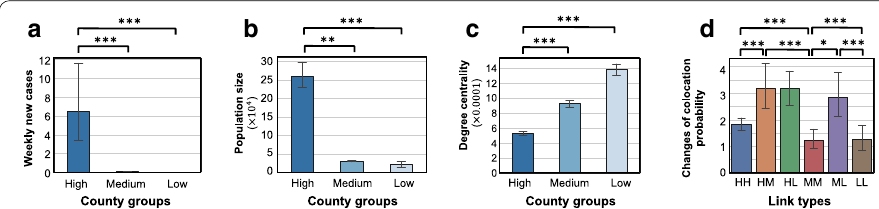
Fig. 7 Wilcoxon rank-sum tests for the metric values across three different county groups. The metrics are: a weekly new cases (first-order growth rate) over the week from March 17 to March 24; b population size; c co-location degree centrality over the week March 31; and d the percentage reduction of the co-location probability for different types of links over the week from March 10 to March 17. HH means the edges connecting two counties both from the high-risk group; HM means the edges connecting one county from high risk group and another county from medium risk group, and so on so forth. (The ranks based on the data in different weeks were performed as a sensitivity test provided in Additional file 1). Note: *** p < 0.01; ** p < 0.05; * p <